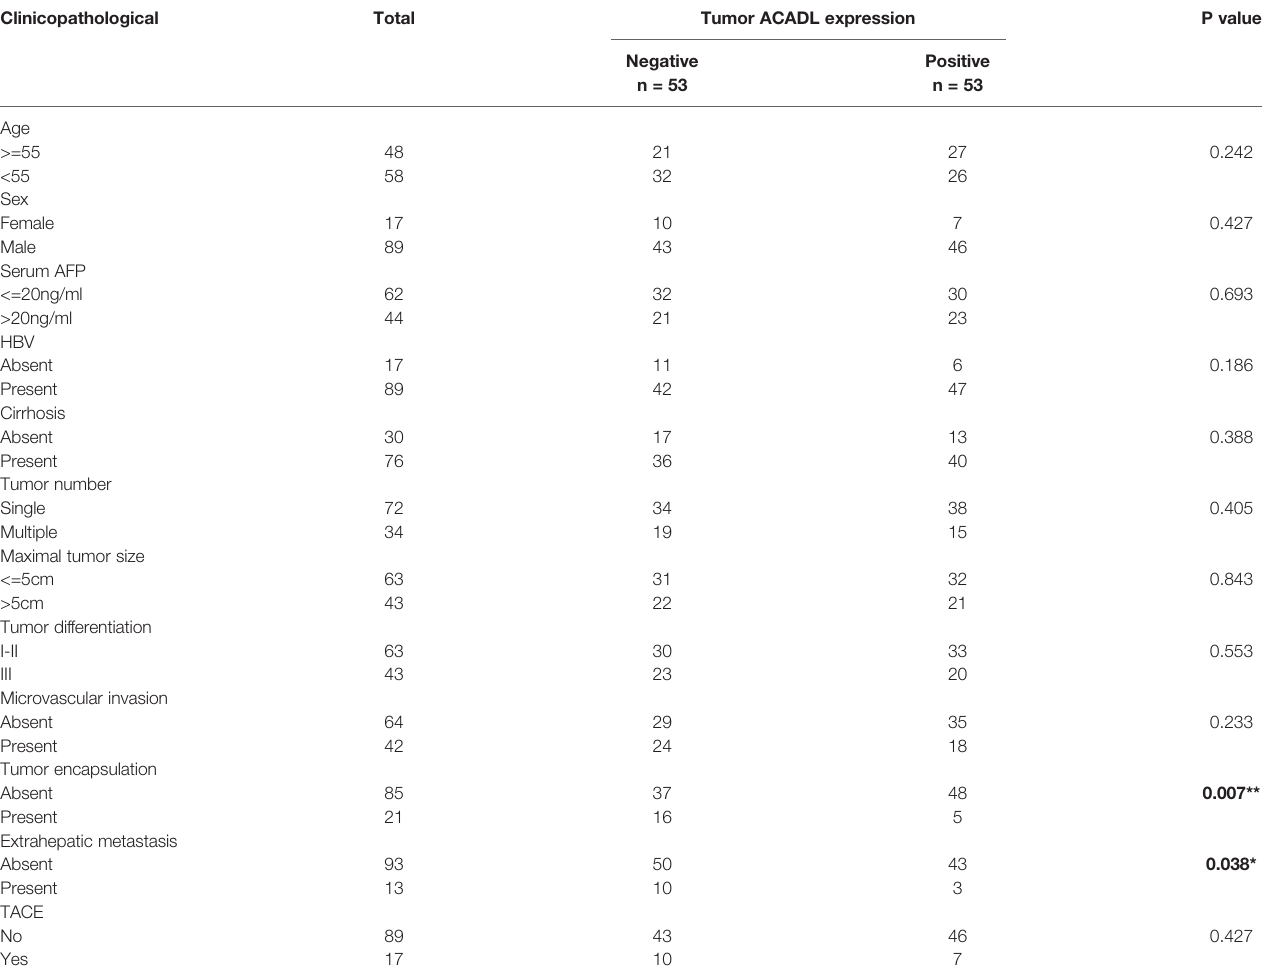
TABLE 1 | Relationship between intratumoral ACADL expression and clinicopathologic features.